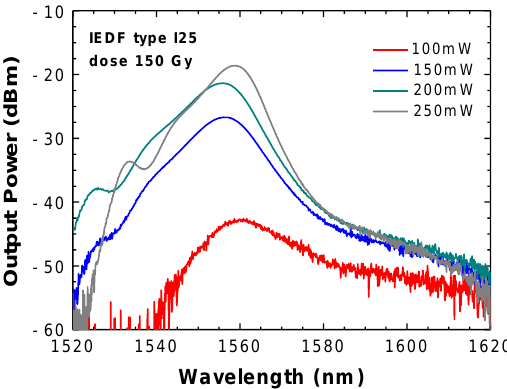
Figure 5. Amplified spontaneous emission (ASE) spectra obtained from a 5 m length of EDF I25 irradiated with 150 Gy when pumped by a 976 nm light source from 100 mW to 250 mW.